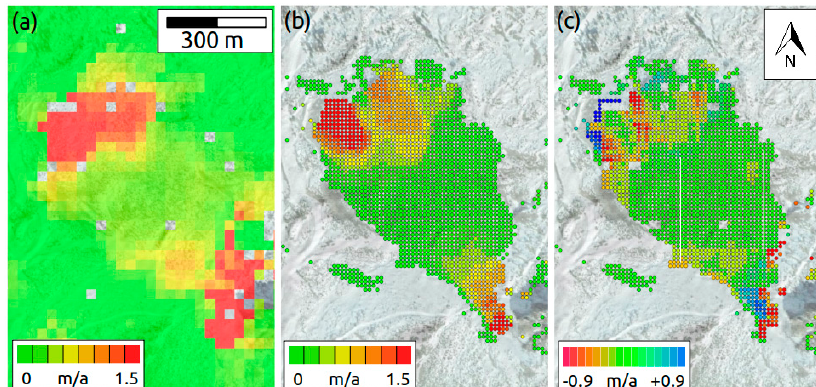
Figure 16. Distelhorn rock glacier (Mattertal, Switzerland). ( a ) Horizontal velocity map from TerraSAR-X offset tracking between 11.09.2014 and 06.09.2016; ( b ) Horizontal velocity map from matching of aerial optical images with a spatial resolution of 0.15 m acquired on 03.09.2014 and 21.09.2017; ( c ) Difference map between aerial photo matching and TerraSAR-X offset tracking velocities.